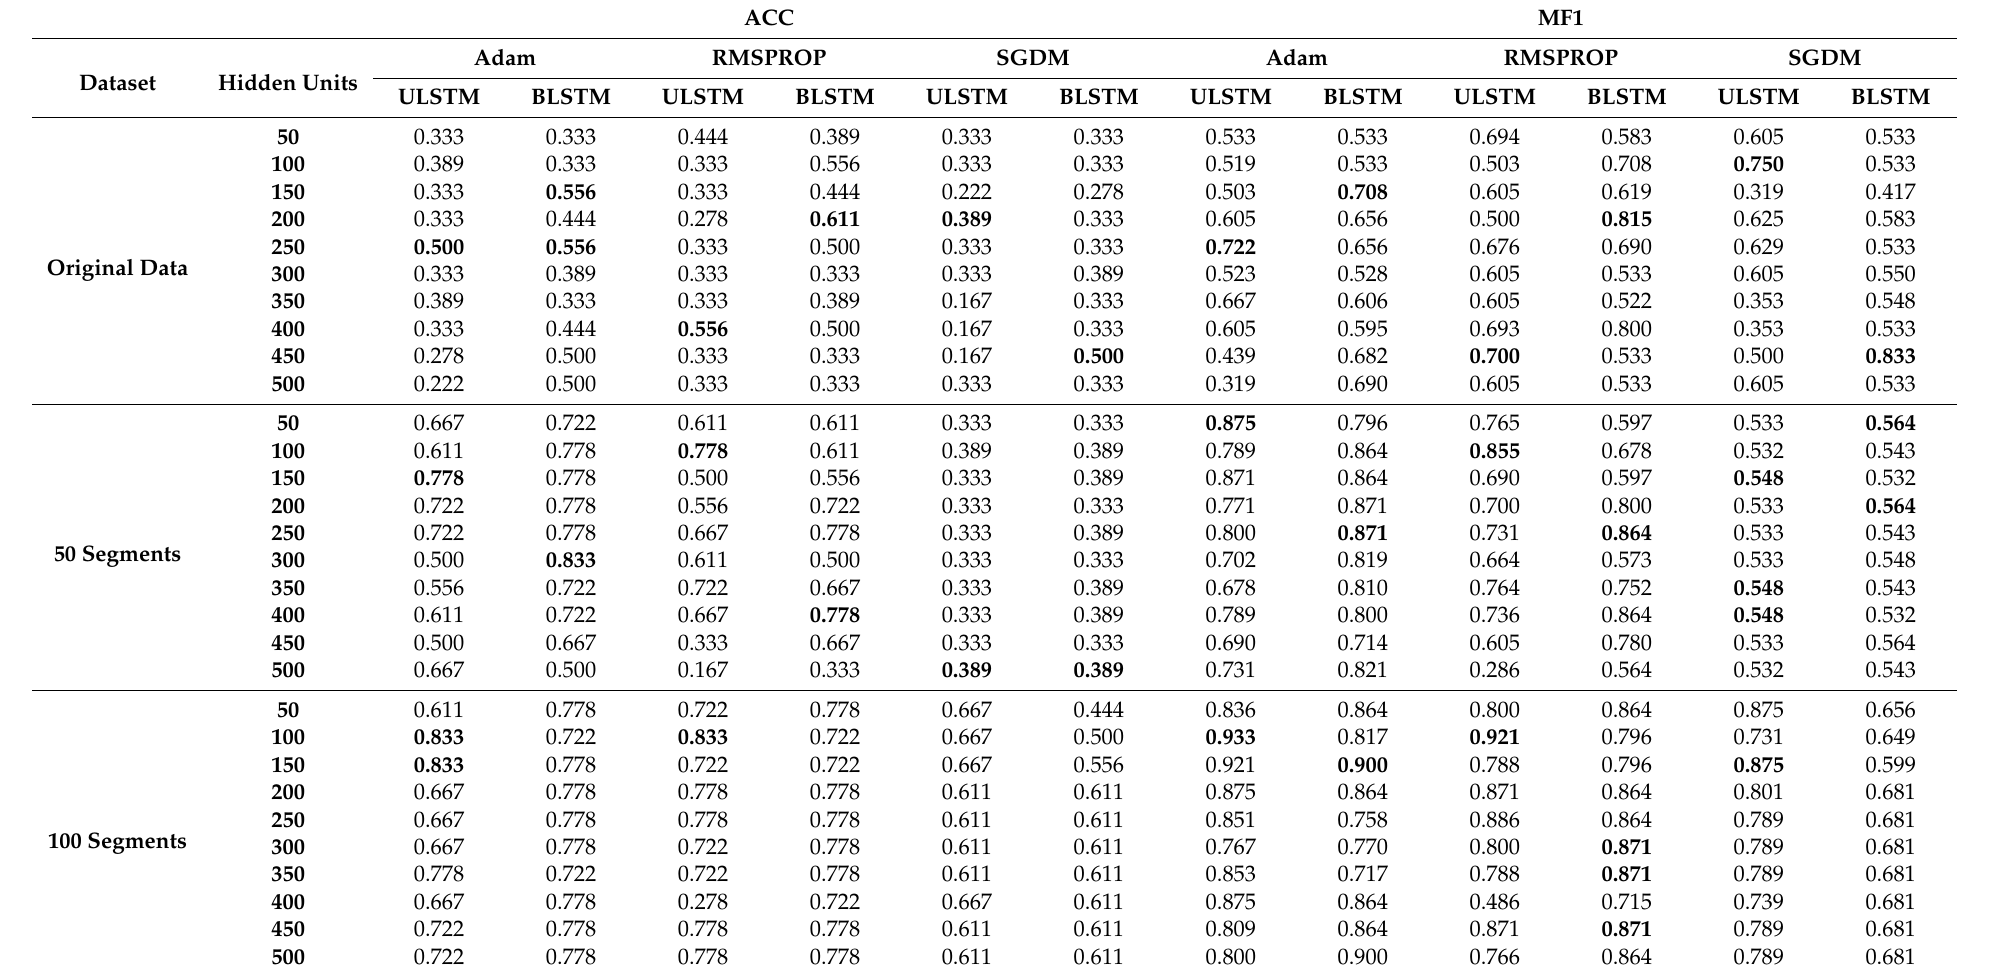
Table 11. Performance metrics of the OD test (control) data from the networks trained with the 31-mer Oestrdiol dataset. ACC